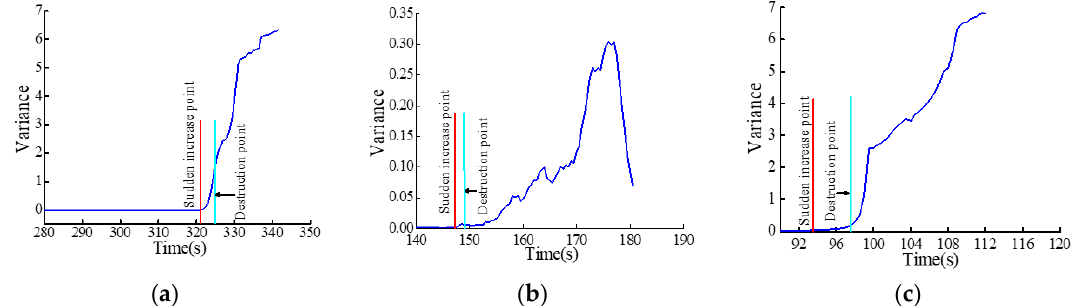
Figure 9. The index of critical slowing down at different loading rates: ( a ) the curve of critical slowing down index under 50 N/s loading rate; ( b ) the curve of critical slowing down index under 100 N/s loading rate and ( c ) the curve of critical slowing down index under 200 N/s.